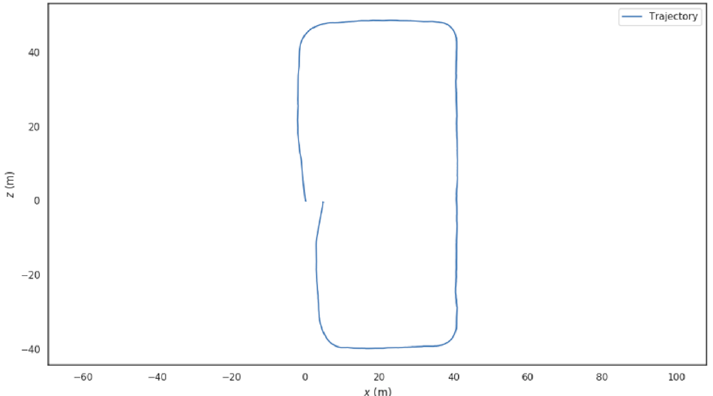
Figure 14. Rectangular trajectory drawn according to the camera motion.